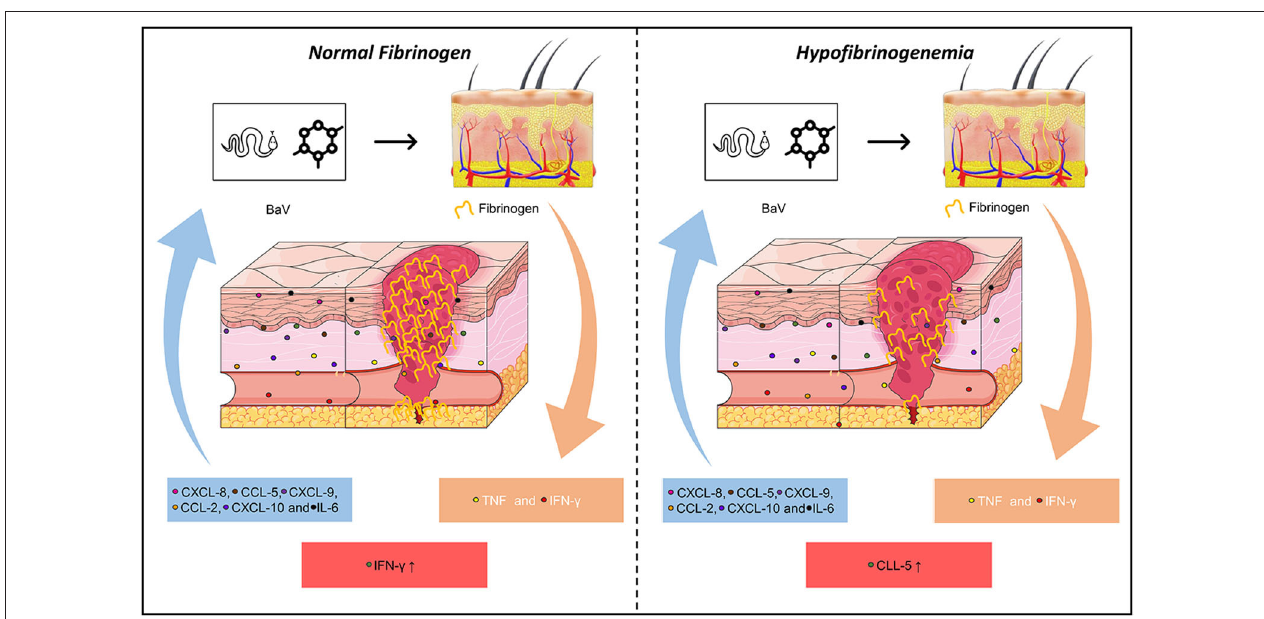
FIGURE 6 | Correlating fibrinogen consumption and profiles of inflammatory molecules in Bothrops atrox snakebite patients. Schematic presentation of inflammation-coagulation crosstalk in patients with normal fibrinogen (NF) and hypofibrinogenemia (HF).